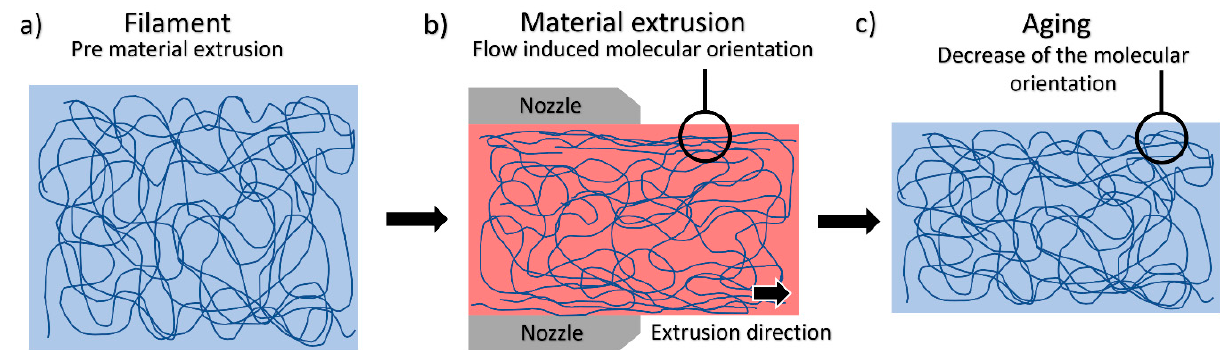
Figure 11. Schematised hypothesis of the flow-induced molecular orientation, relaxed during the ageing: ( a ) randomly distributed polymer chains; ( b ) extrusion process with the flow-induced molecular orientation on the surface; ( c ) ageing effect on the flow-induced molecular orientation; the orientation is partially lost.